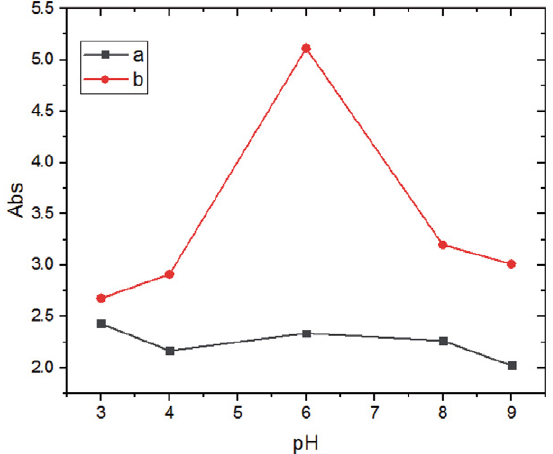
Figure 4. Effect of pH on the drug adsorption a ( Gr Mn / GO / CS / A. sativum / Que), b ( Mn / GO / CS / A. sativum /